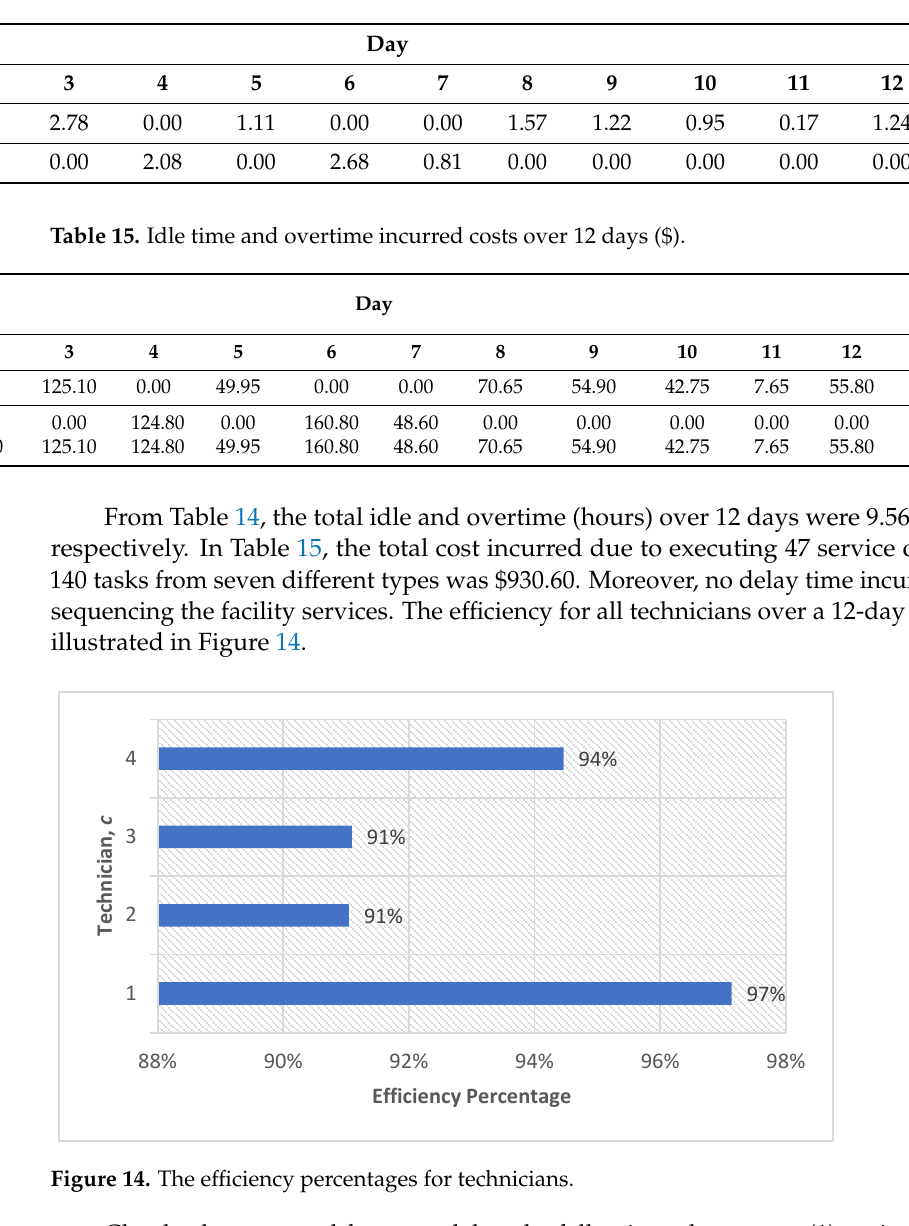
Table 14. Idle time and overtime hours over 12 days (h).